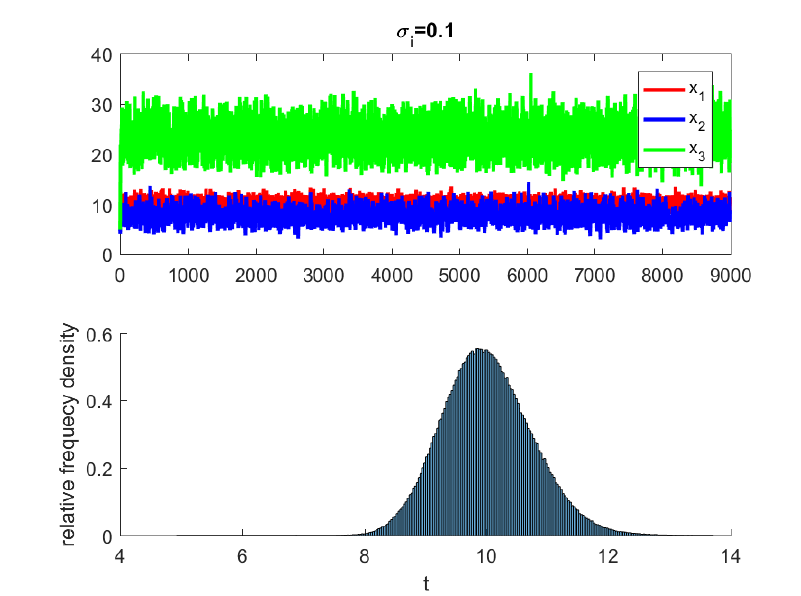
Figure 5. The density function of susceptible mice of the Hantavirus infection system